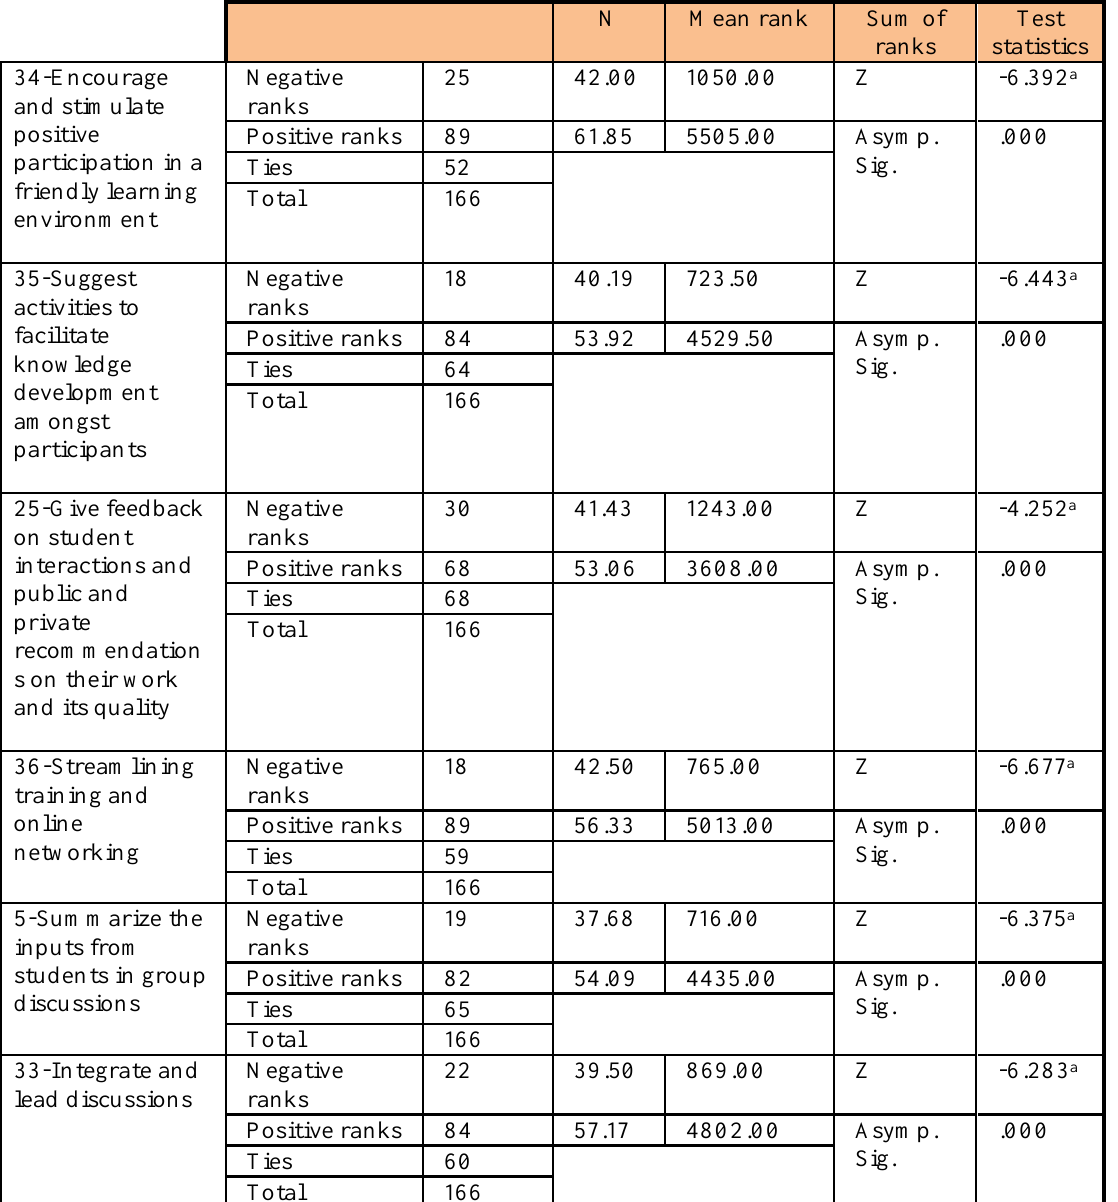
Table 2 Wilcoxon Signed Ranks Test. Median Difference on the Level of Proficiency and Professional Development Needs Regarding the Social Role Competencies Applied to Online